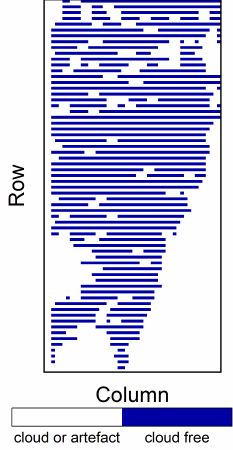
Figure 3. Exemplary representation of the pixels of the detector field after filtering. The continuous white lines in the rows are measurement artefacts due to problems with the readout electronics during the